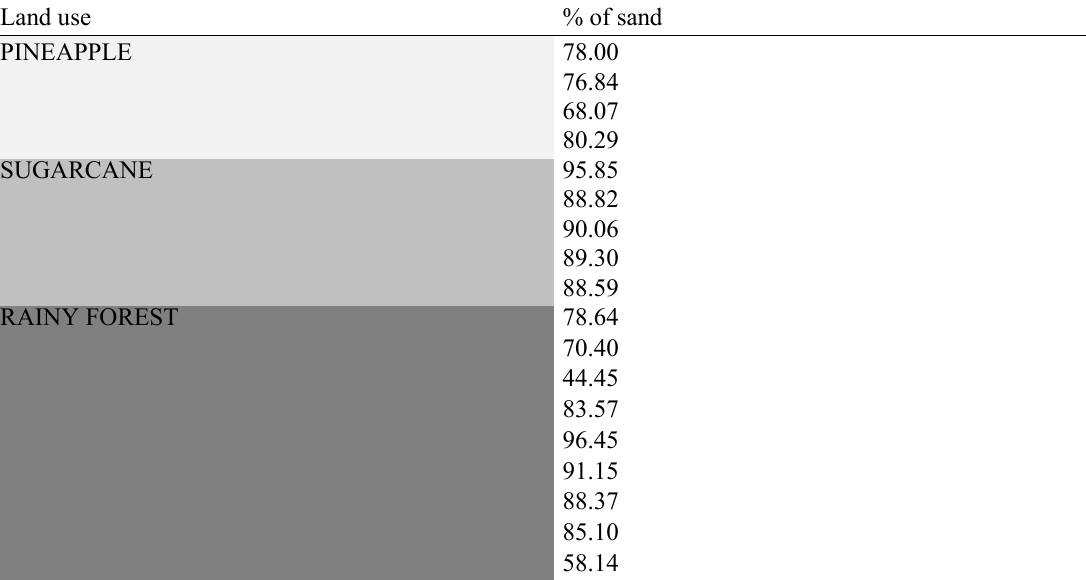
Table 1 Percentage of sand according to the land uses. Land use % of sand PINEAPPLE